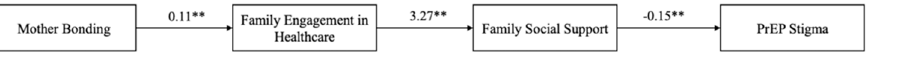
Figure 1. Direct pathways to reduction in PrEP stigma through mother bonding, ( n = 399). Note: standardized path coefficients presented. ** p < 0.01.